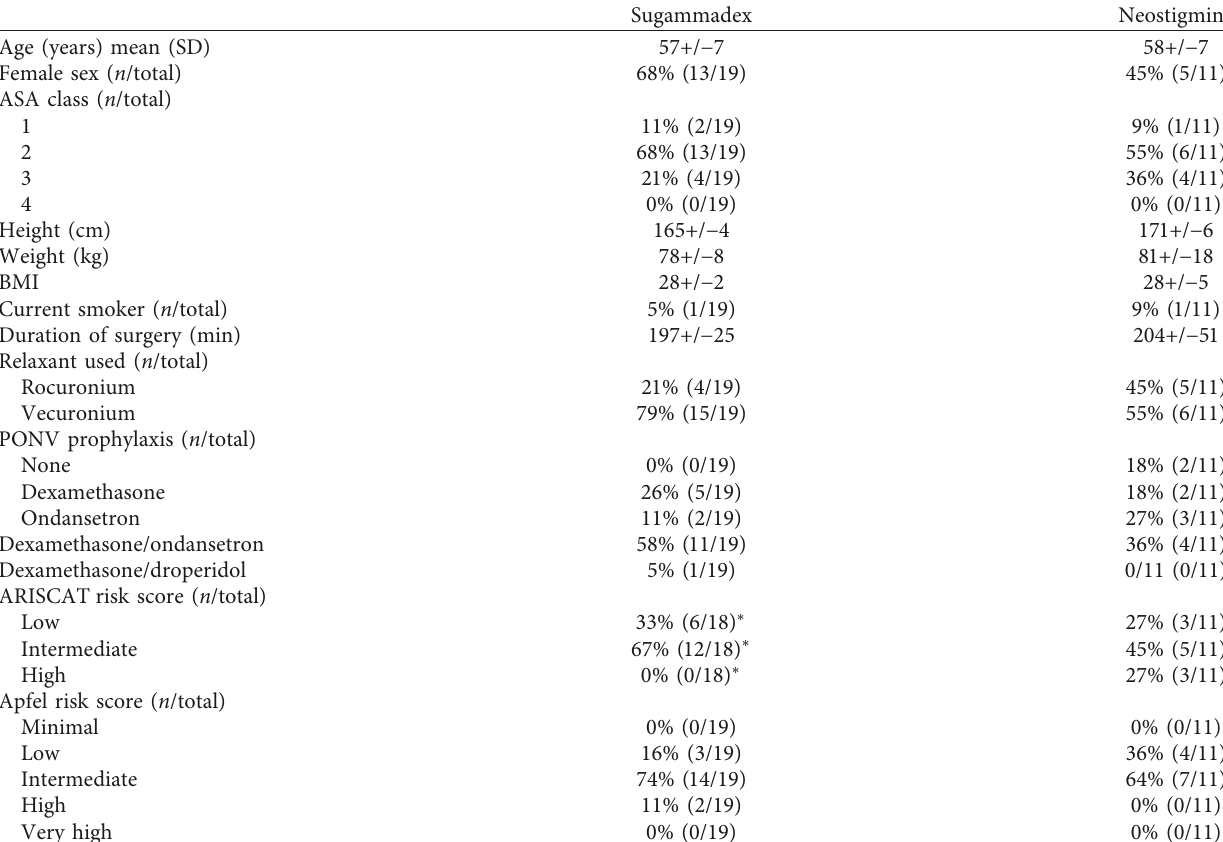
Table 2: Demographic characteristics of study participants.